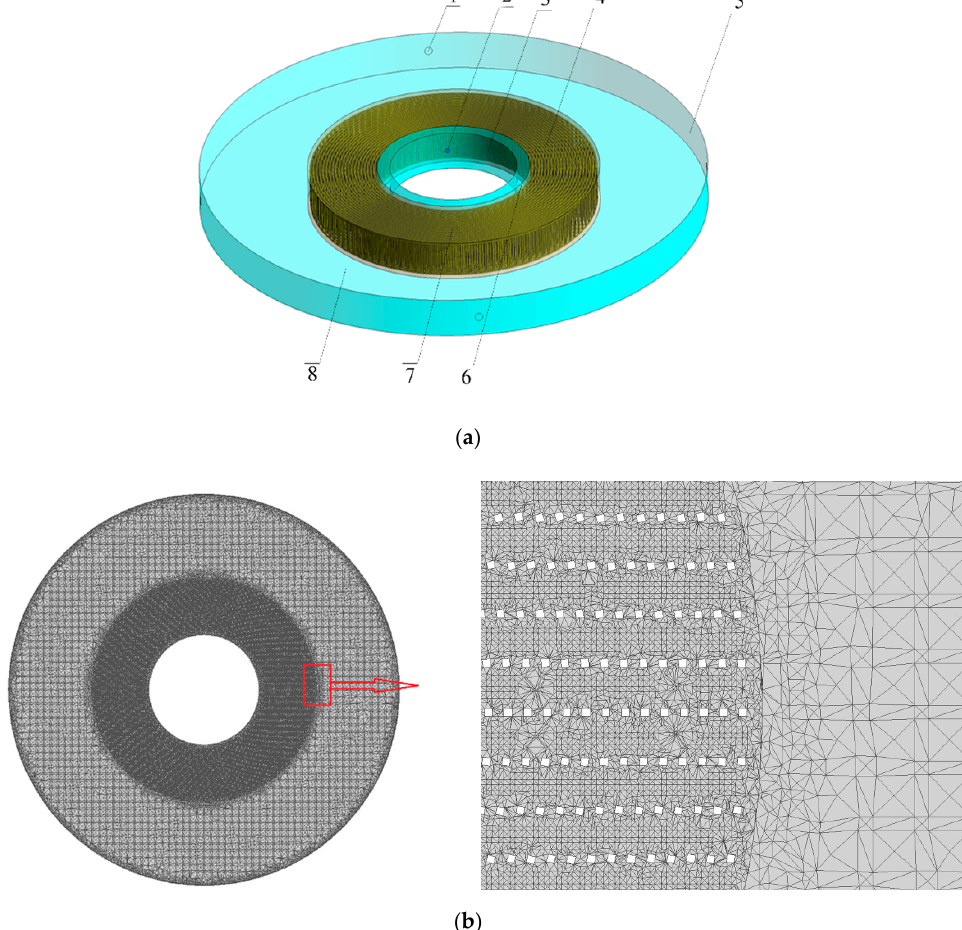
Figure 3. ( a ) 3D physical model diagram (1, gas inlet; 2, liquid inlet; 3, gas outlet; 4, foursquare obstacles; 5, liquid outlet; 6, end zone; 7, packing zone; 8, cavity zone). ( b ) Grid refinement.